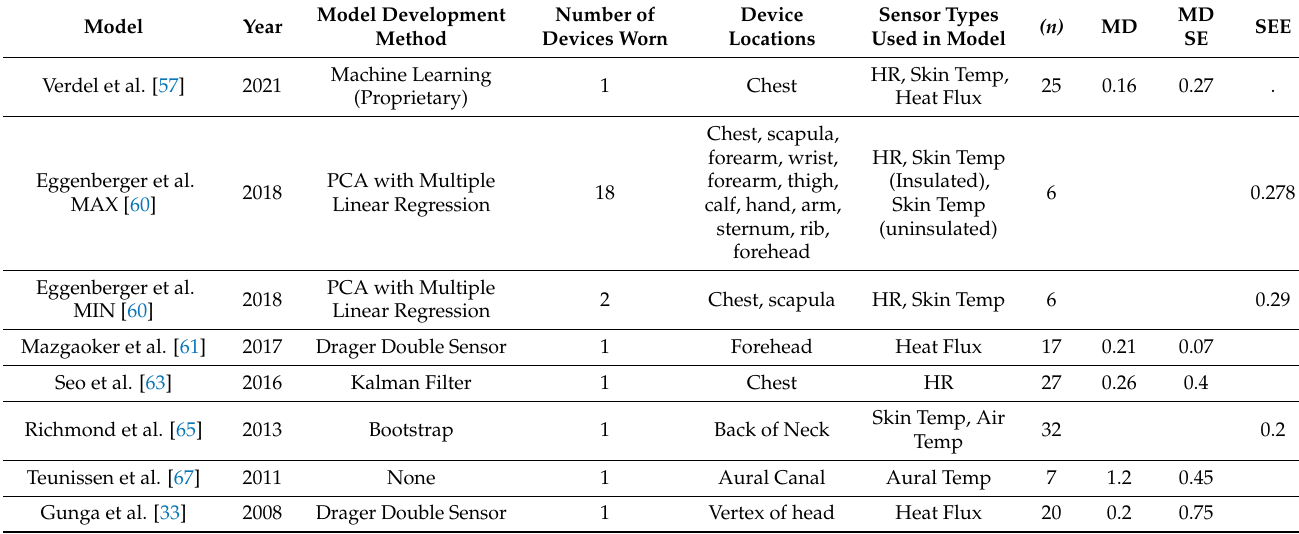
Table 5. Data on the model design and outcomes for models that reported the mean difference or standard error of the